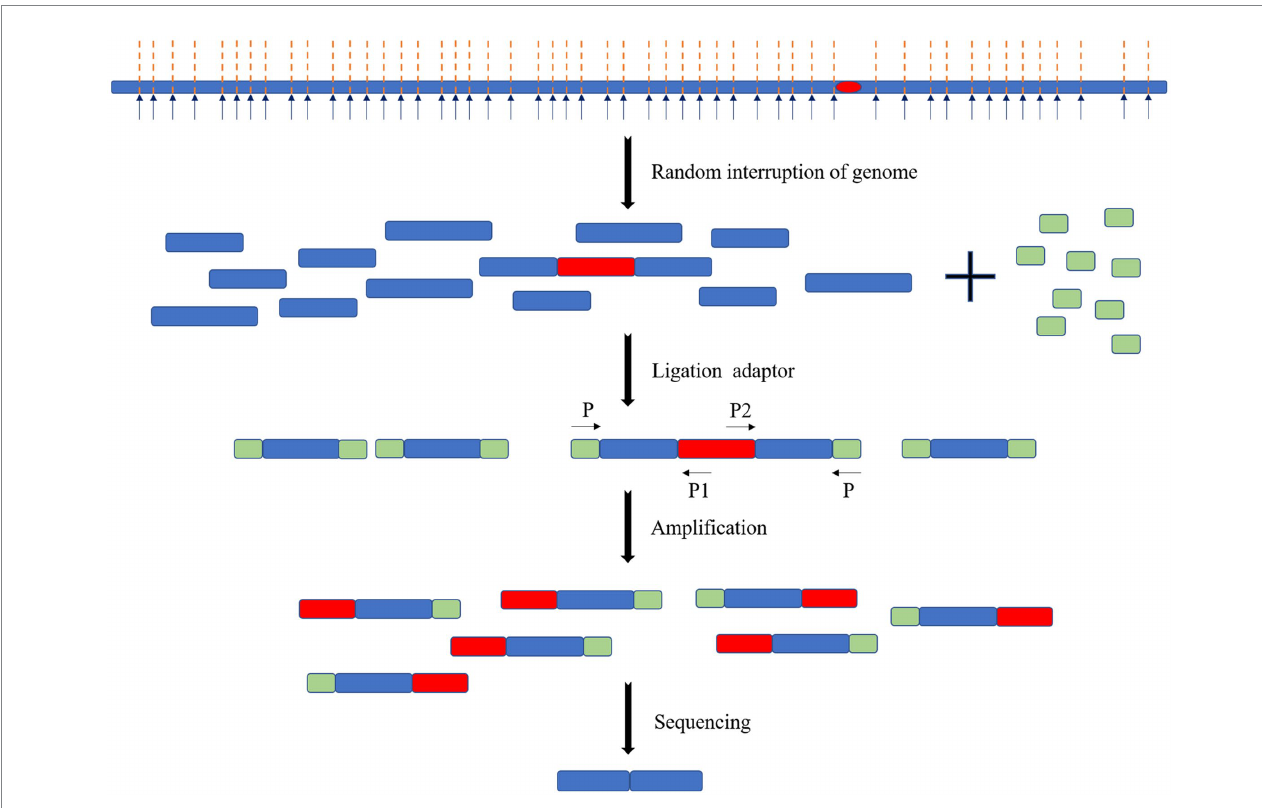
FIGURE 8 Schematic diagram of the Tn-Seq principle. The genome of the transposon insert was randomly interrupted. The splice sequence is added, and primers are designed with the specific sequences of the splice sequence and transposon for amplification and sequencing.